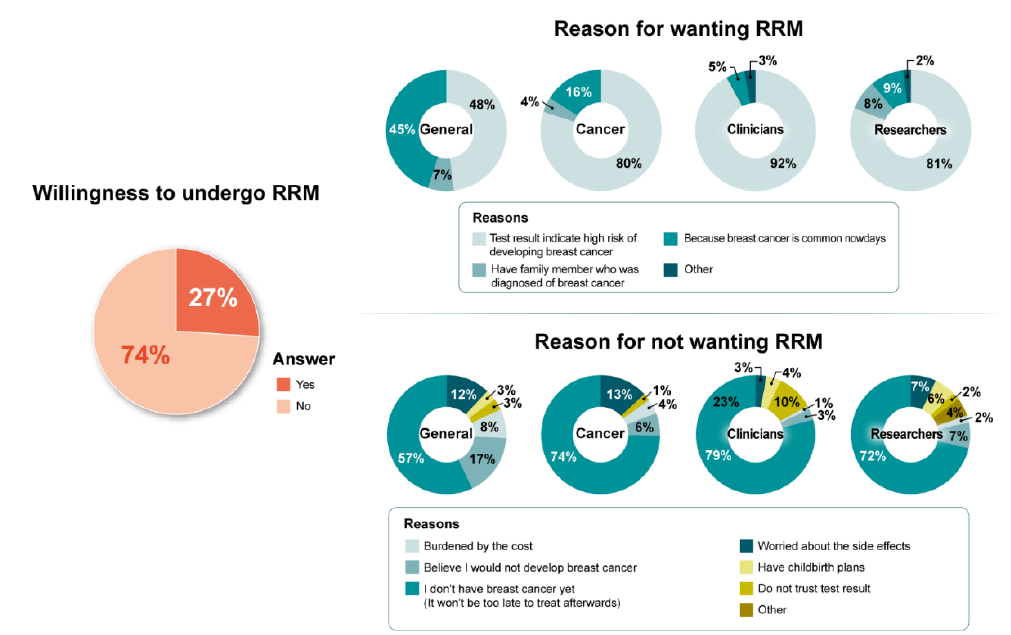
Figure 3. Intent to undergo risk-reducing mastectomy (RRM) and its reasons by respondent